Question: Does the figure show an increasing or a decreasing trend?
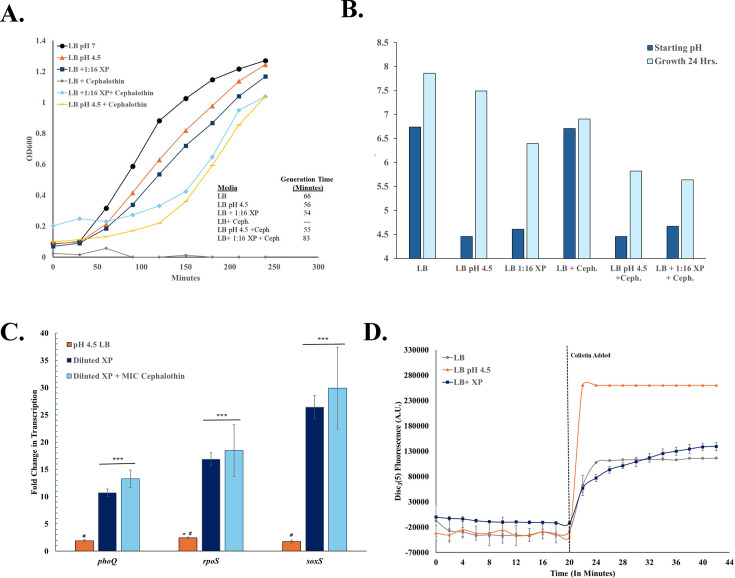
Answer: increasing